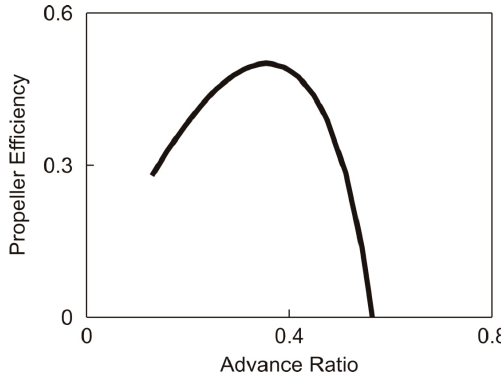
Figure 9. Propeller efficiency of a small-scale propeller (reproduced in part from [26], propeller diameter: 0.2286 m).